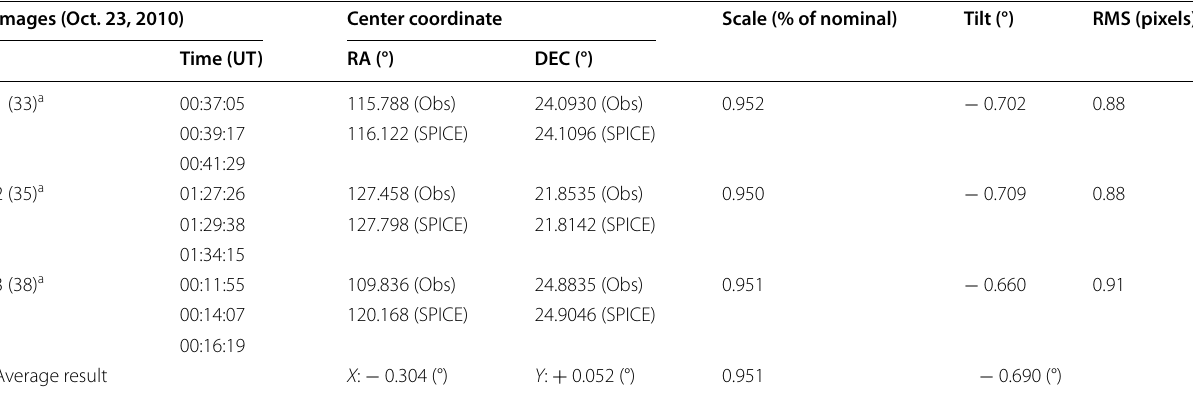
a Numbers in parentheses are number of star position measurements in the image